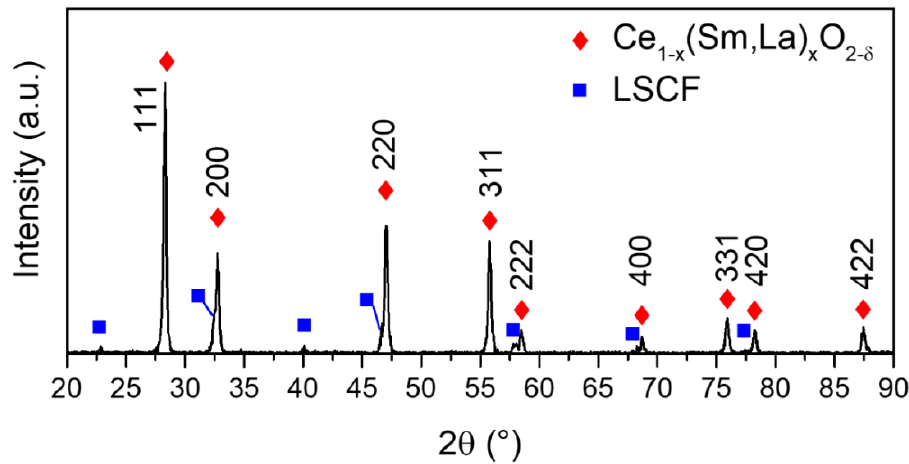
Figure 5. Low incidence angle (2°) X-ray diffractogram of the cathode–electrolyte interface after the selective dissolution of LSCF.